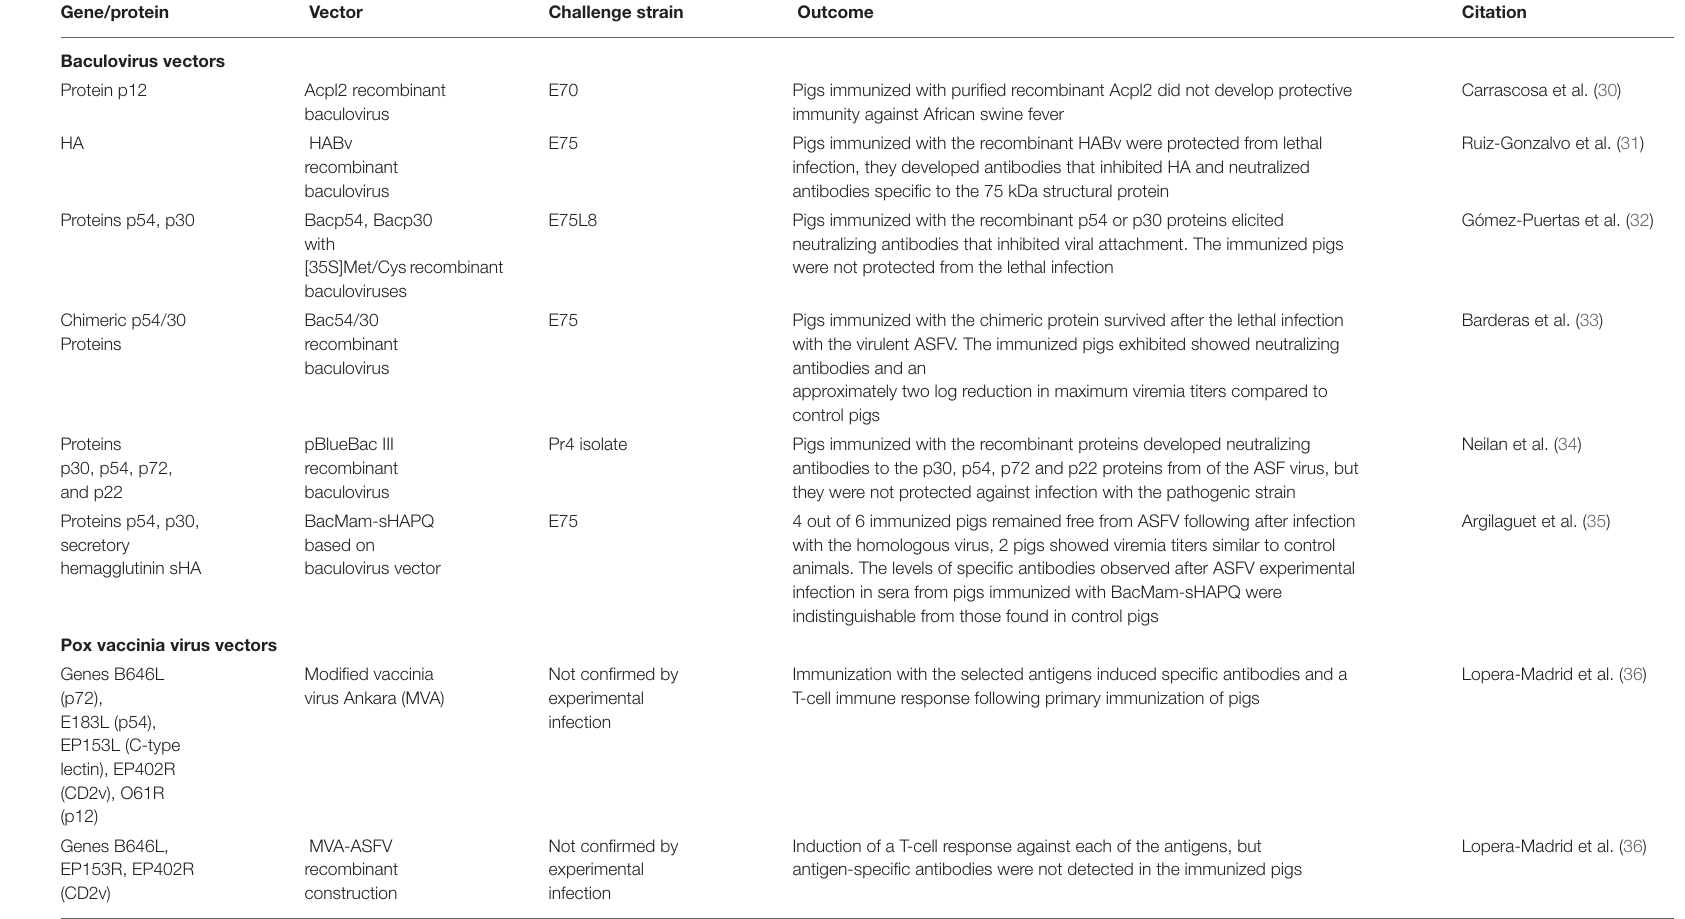
TABLE 1 | Known viral vectors used in the development of an ASF vaccine or as a carrier of ASF genes fragments.